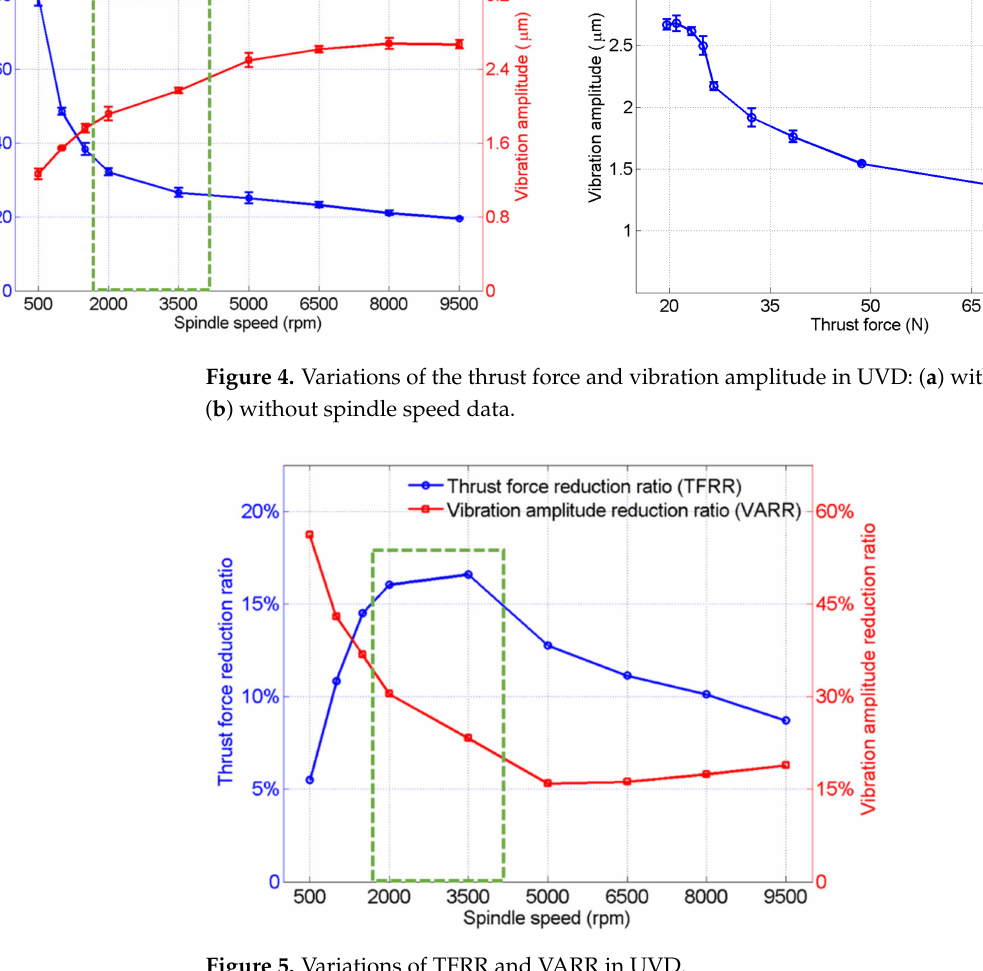
Figure 5. Variations of TFRR and VARR in